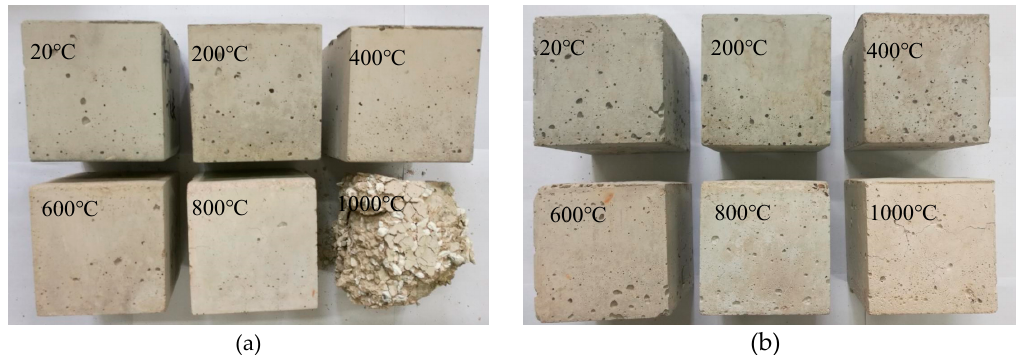
Figure 4. Appearance changes of concrete specimens after exposure to high temperature: ( a ) NC; ( b ) LC-100.